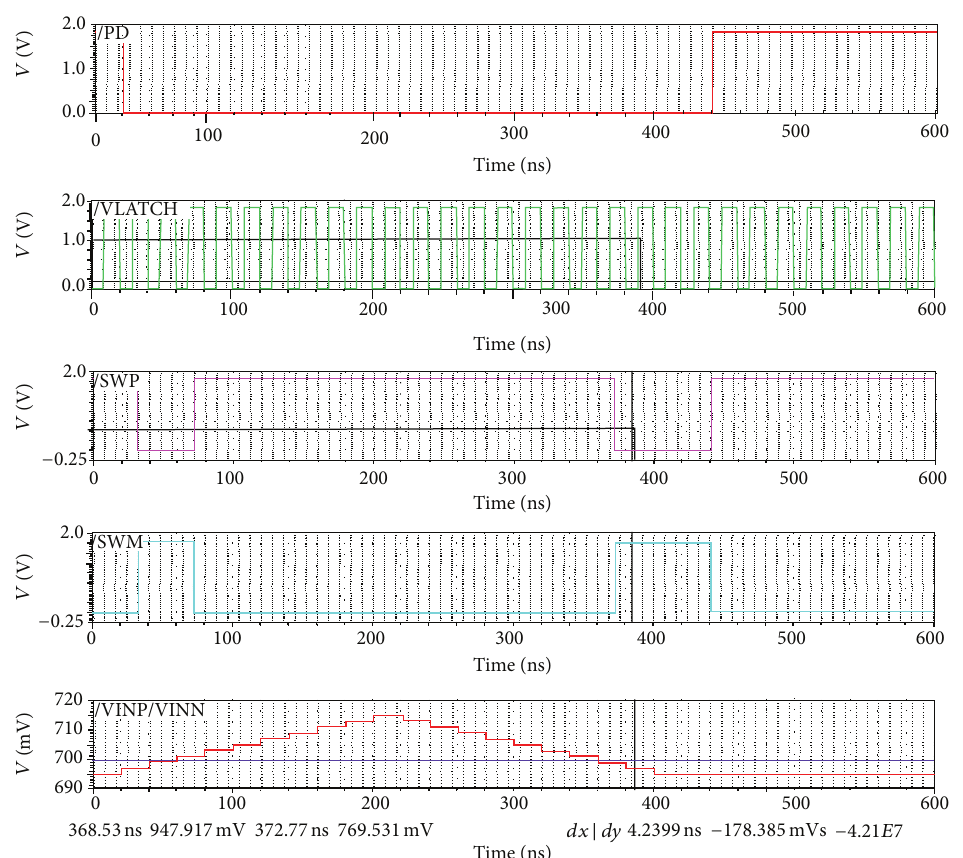
Figure 3: Propagation delay waveform between the VLATCH and SWP signal.